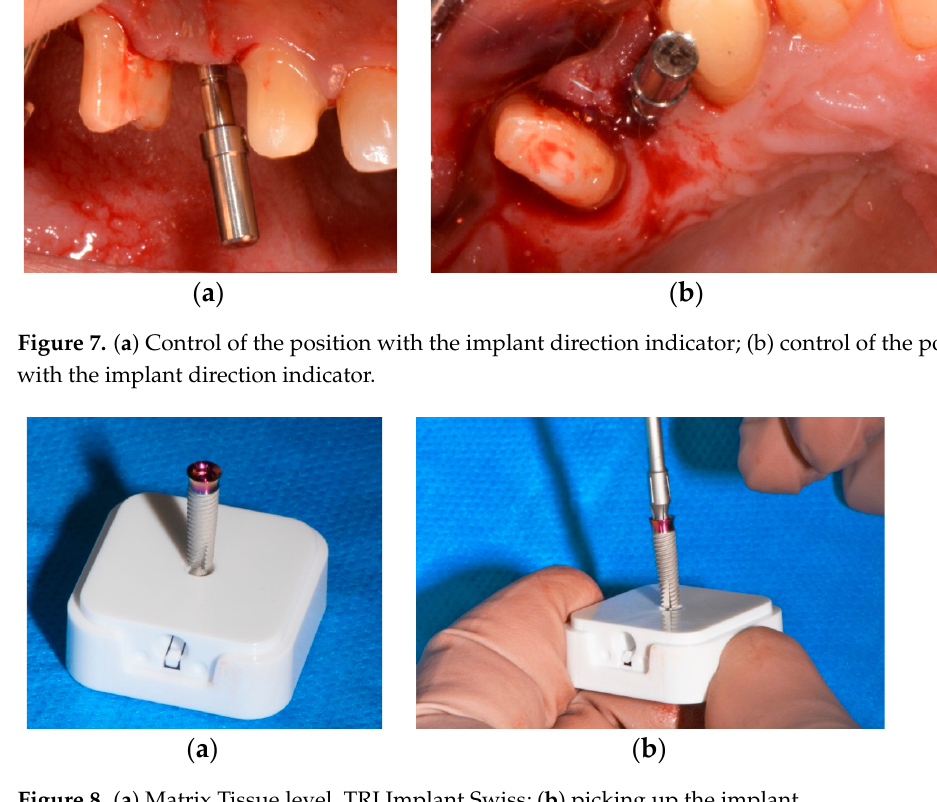
Figure 8. ( a ) Matrix Tissue level, TRI Implant Swiss; ( b ) picking up the implant.